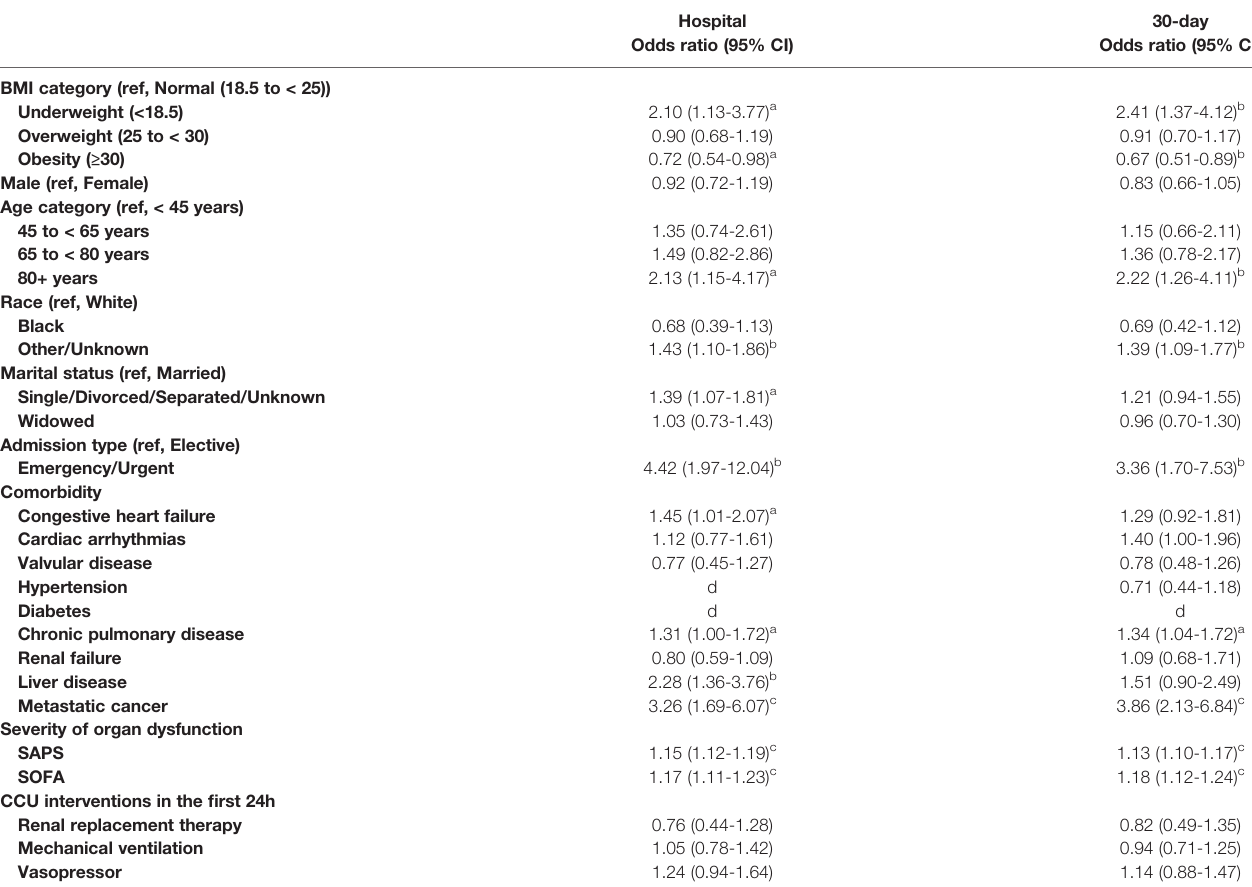
TABLE 3 | Multivariable logistic regression results for hospital and 30-day